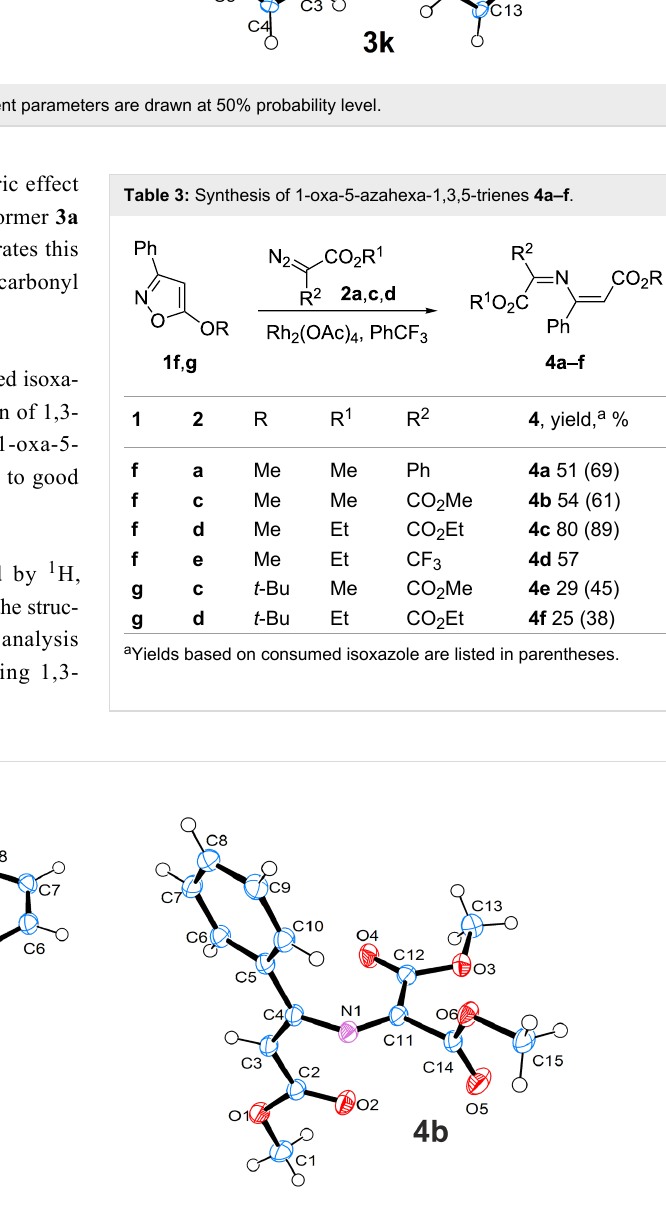
Figure 4: Molecular structures of compounds 4a , b , displacement parameters are drawn at 50% probability level.